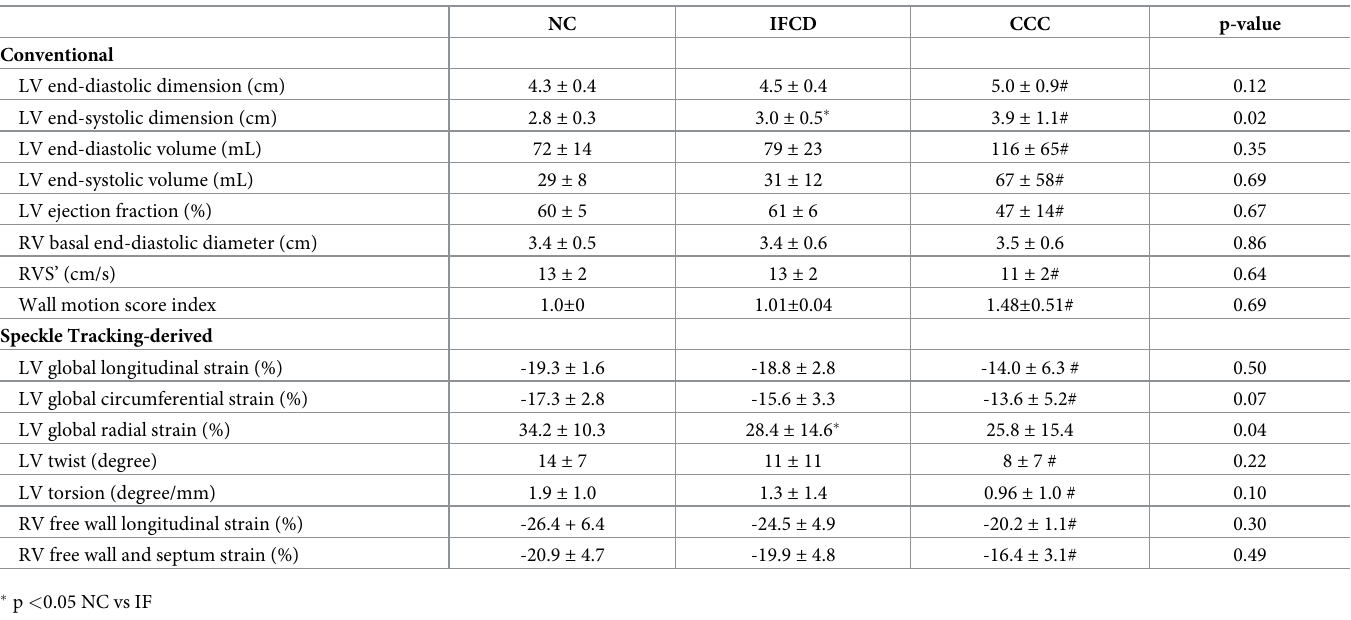
Table 2. Echocardiographic parameters of LV and RV structure and function across the groups.